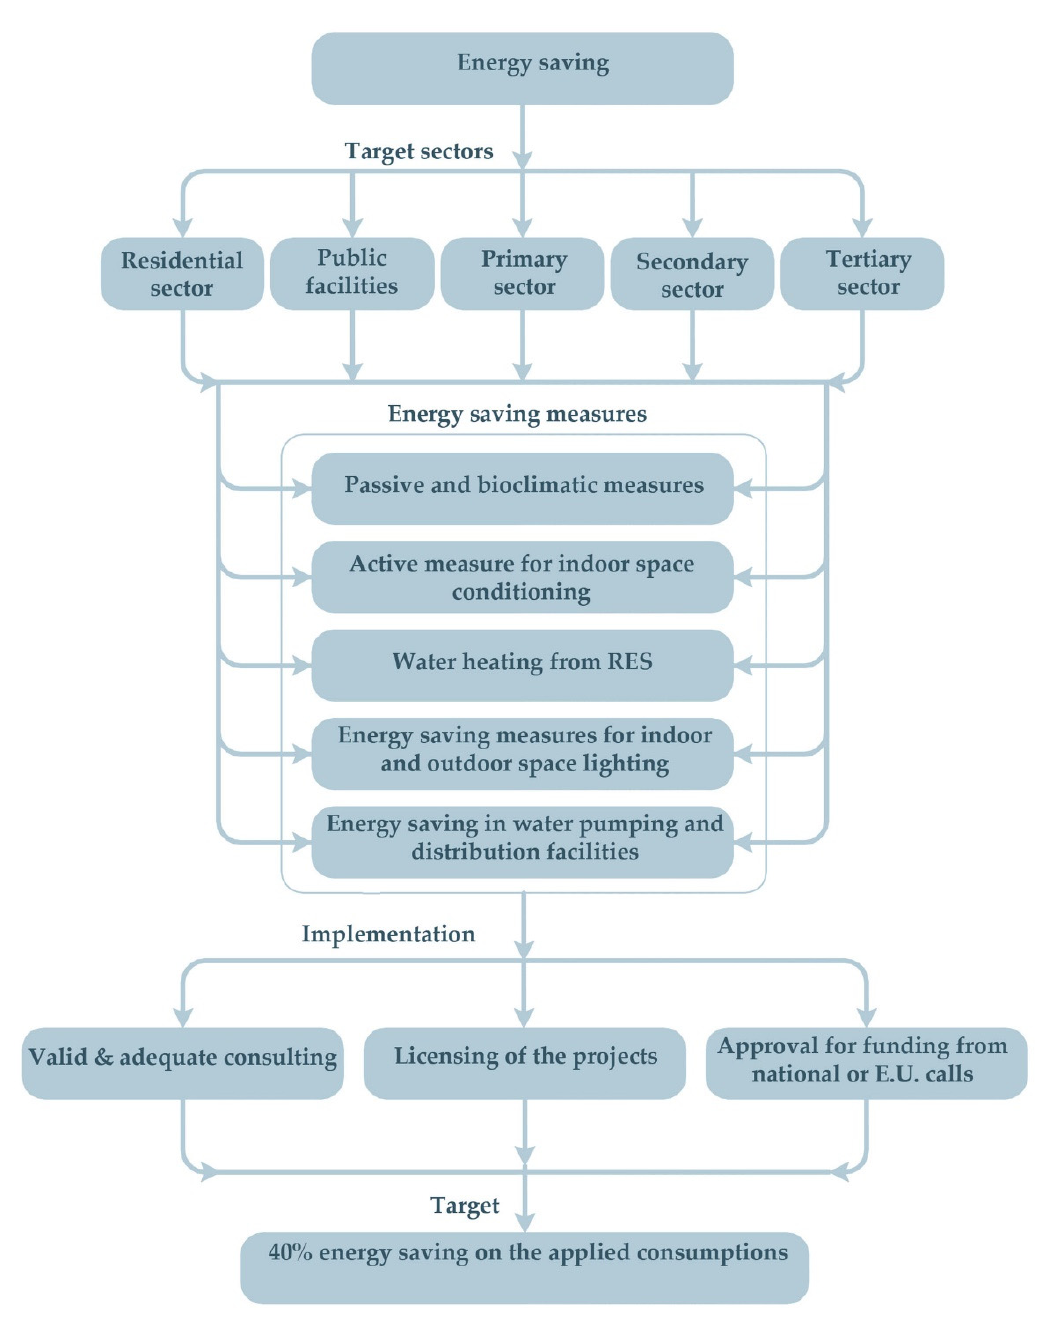
Figure 13. Suggested roadmap for the successful and effective implementation of energy saving in all sectors in Crete.